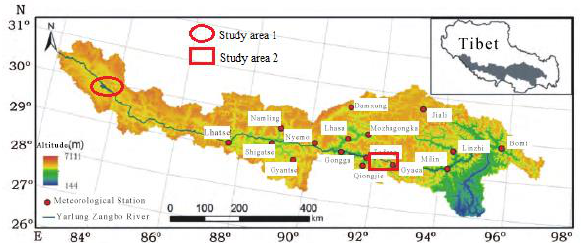
Figure 1. Location of study area in Yarlung Zangbo River (Modified from (Lv,